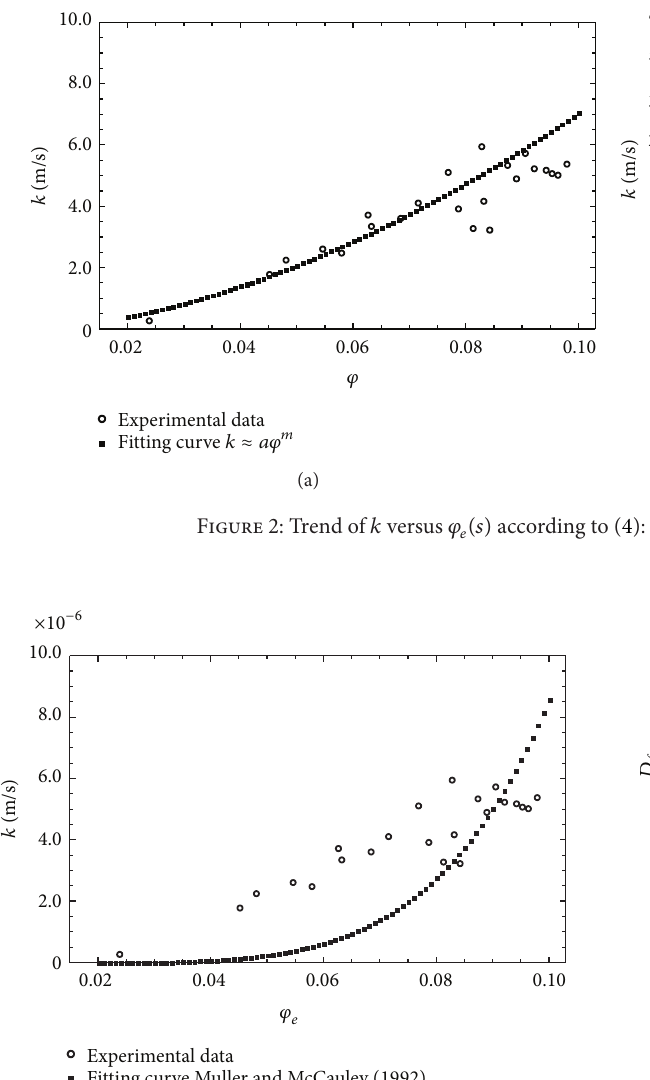
Figure 4: Relationship between fractal dimensions and porosity for different ratios 𝜆 min /𝜆 max according to Xu and Yu [36]